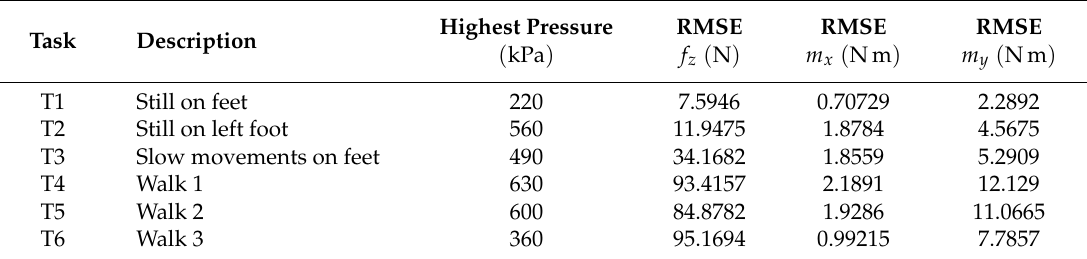
Table 1. Root Mean Square Error (RMSE) analysis of vertical ground reaction force f z ( N ) and horizontal moments m x , m y ( Nm ) , respectively, from tasks T1 to T6.